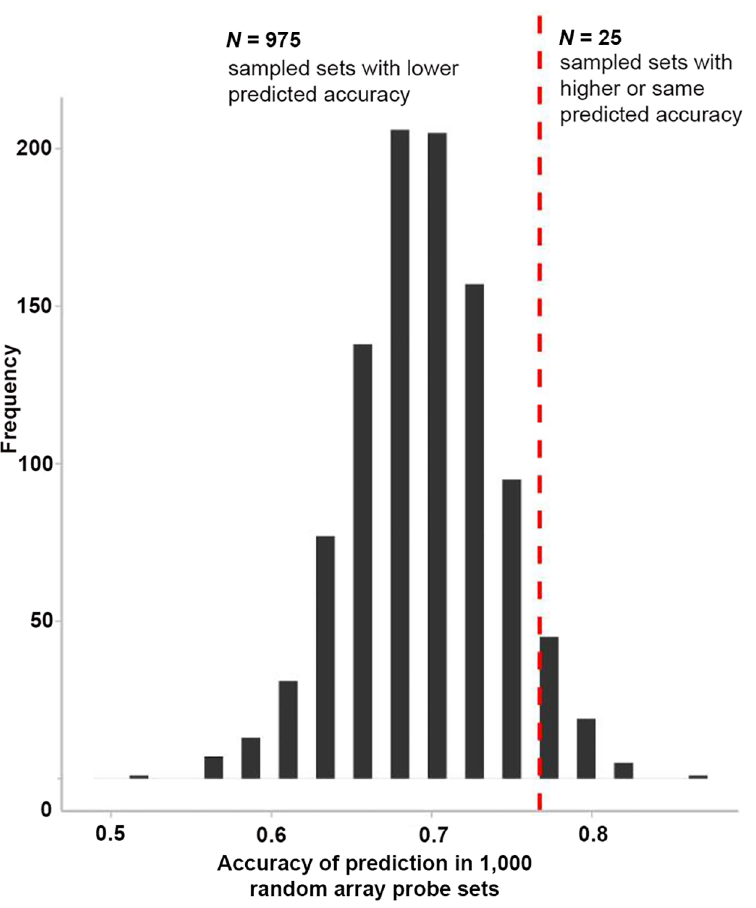
Fig 5. Classification features selectedfrom differential gene expression in a mouse model for antidepressant treatment response are informative for treatment response in a human gene expression data set. Histogram shows the distributionof predictionaccuracy over 1,000 simulated classification models that were computedwith randomly chosen gene expressionprobe sets from human gene expressiondata (median predictionaccuracy= 69.77%). The red dashedline marks the observed prediction accuracy (76.74%)when using our informedfeature selectionto build classifiers. Becauseonly 25 of the randomly chosen feature sets yield equal or better classificationresults, the predictive ability of our features selectedfrom the presented mouse model is significantly greater than expectedby chance ( p = 0.026). All raw data for Fig 5 are available in S1